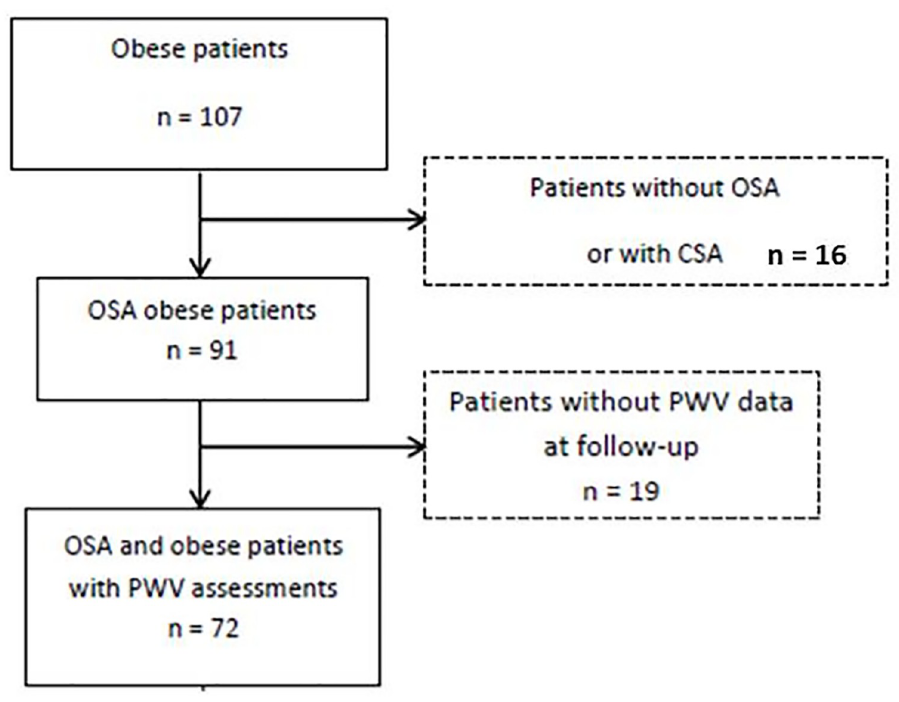
Fig 1. Study flow chart. CSA, central sleep apnea; OSA, obstructive sleep apnea; PWV, pulse wave velocity.